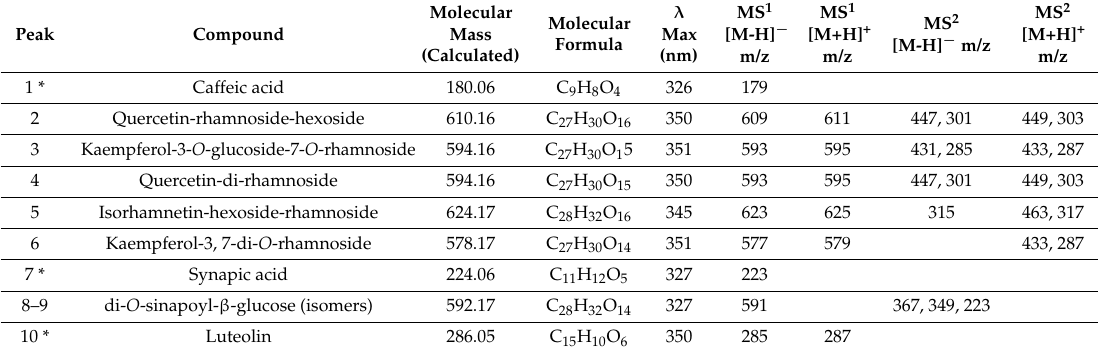
Figure 1. Chromatographic analysis of Arabidopsis thaliana seedlings polyphenols extracted with ethyl acetate from raw juice, registered at 280 nm. Peaks numbered 1–10 are reported in Table 1. Table 1. Compound identification by combined UPLC-DAD-MS and